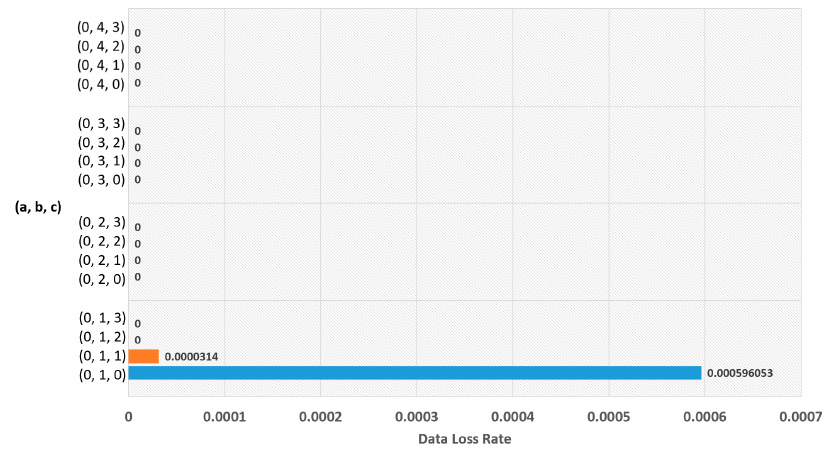
Figure 8. Data loss rate in case of using polynomial function with ‘a’ = 0.